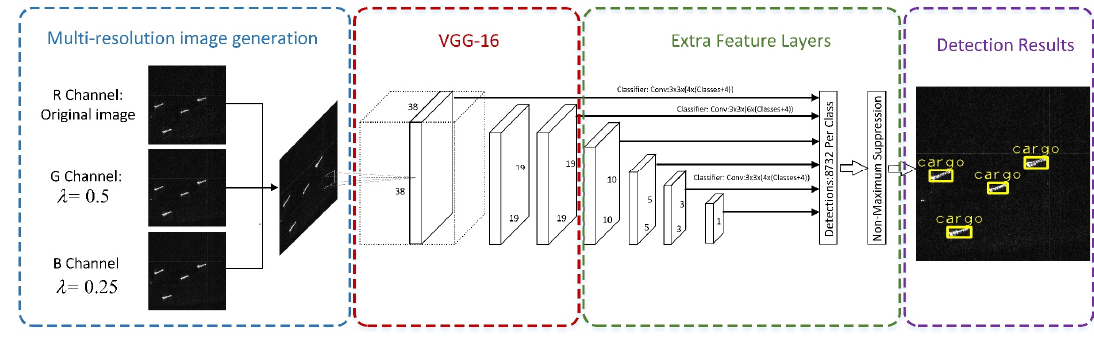
Figure 3. Structure of the MR-SSD. 239